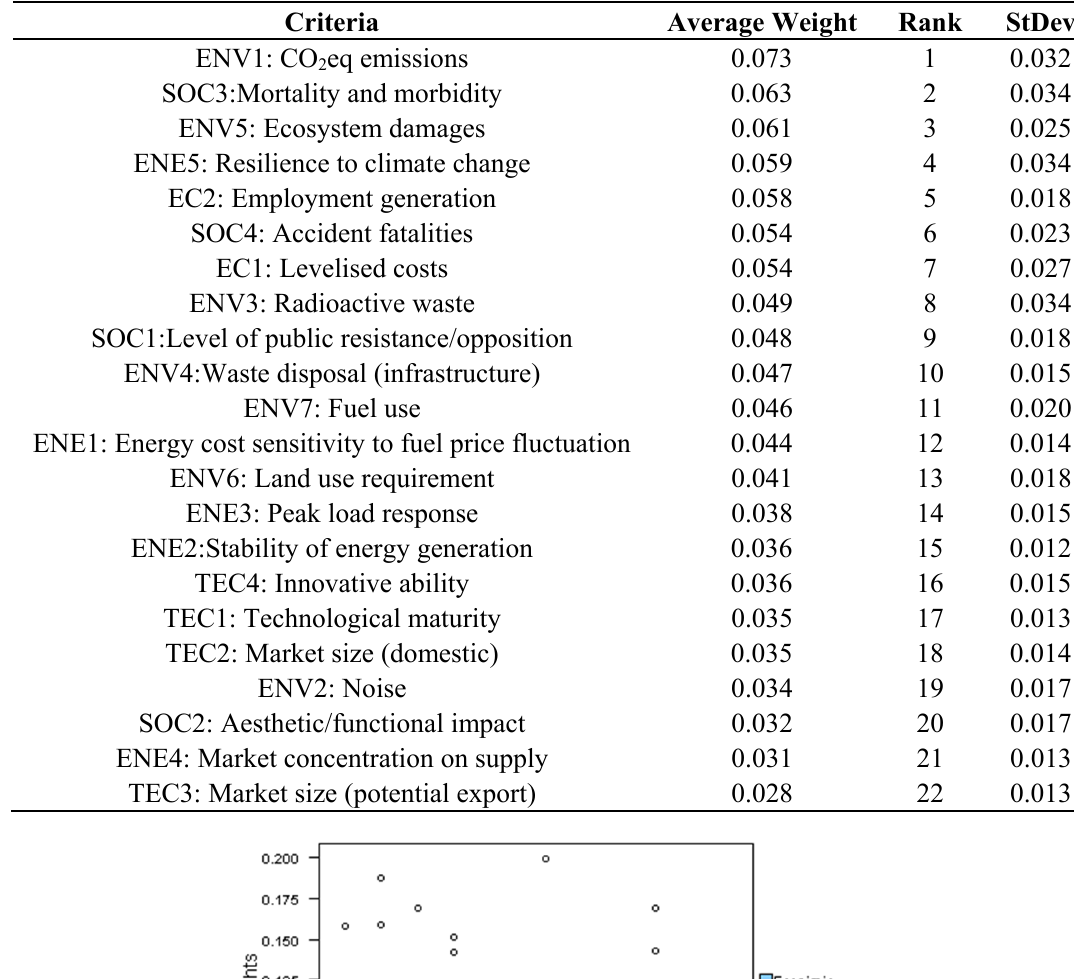
Table 2. Final average weights of criteria, final ranking and standard deviation.